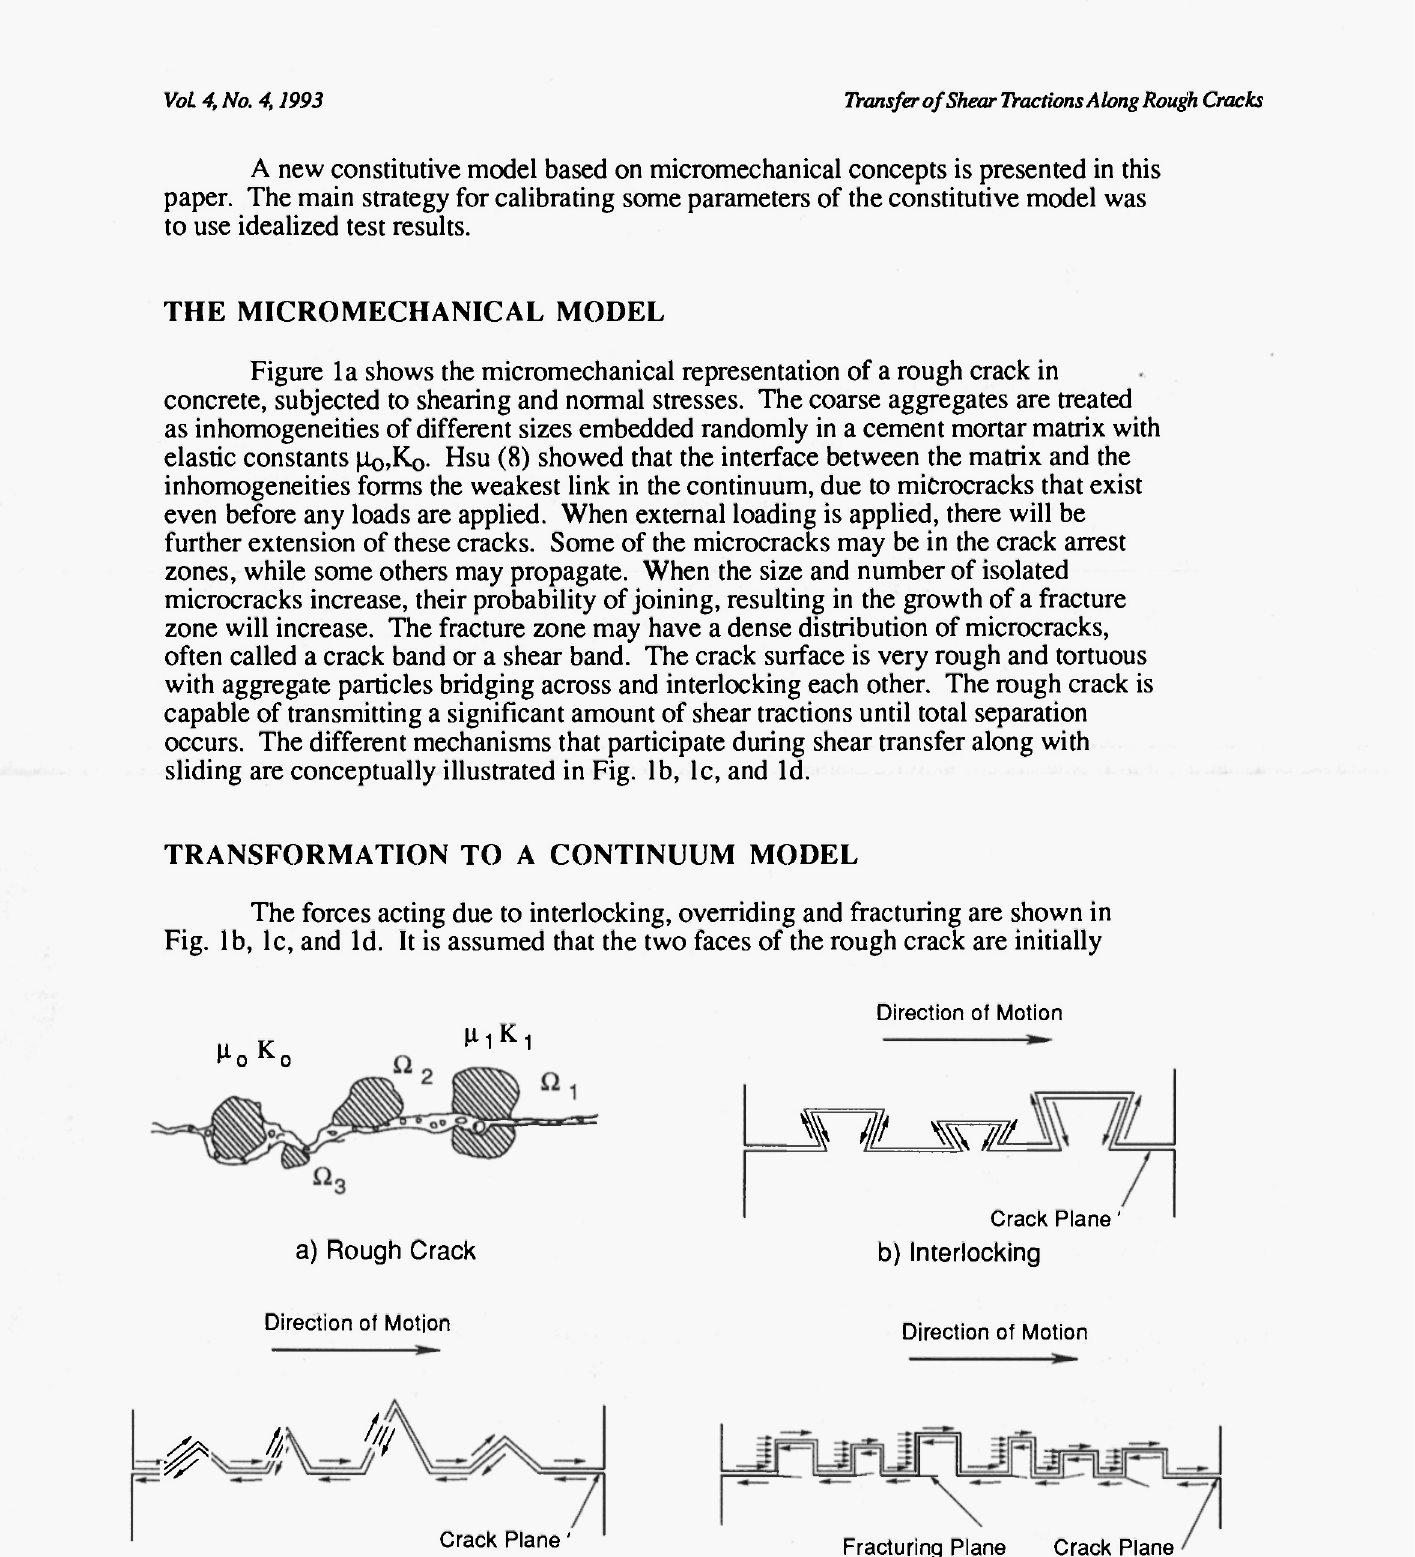
Fig. 1 Micromechanics Representation of a Rough